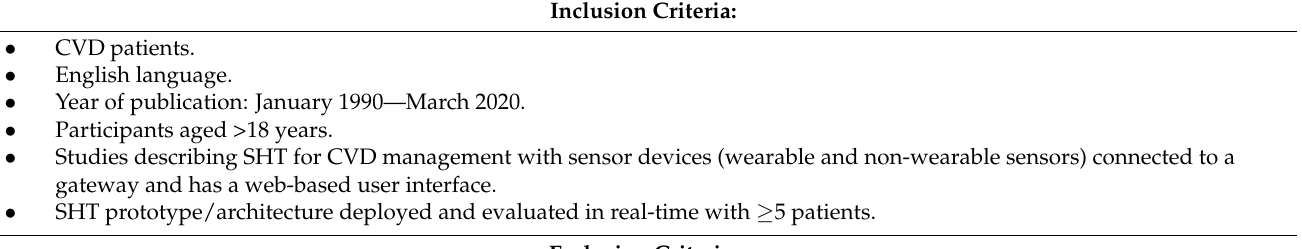
Table 1. Selection criteria for review articles (adapted from reference [43]).